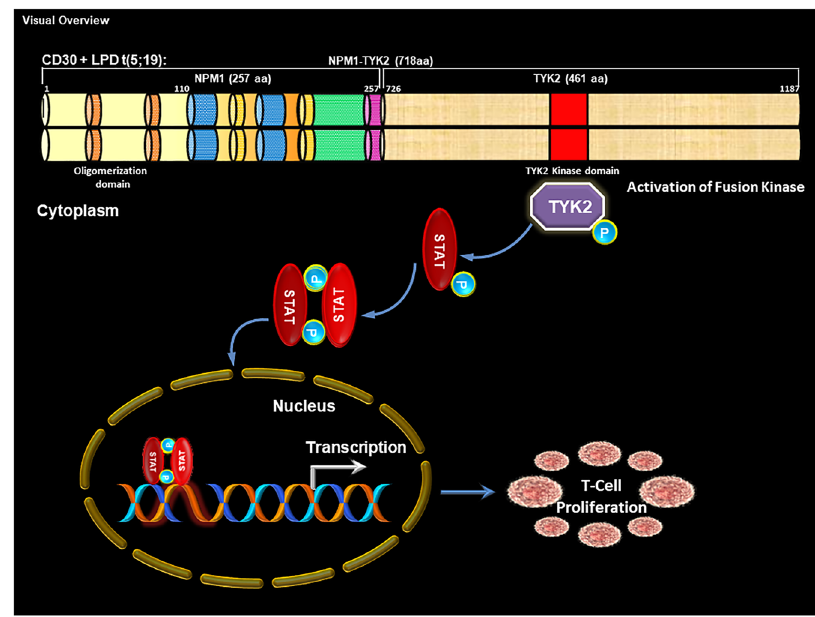
Fig. 9 Visual overview. NPM1-TYK2 fusion mediated oncogenic